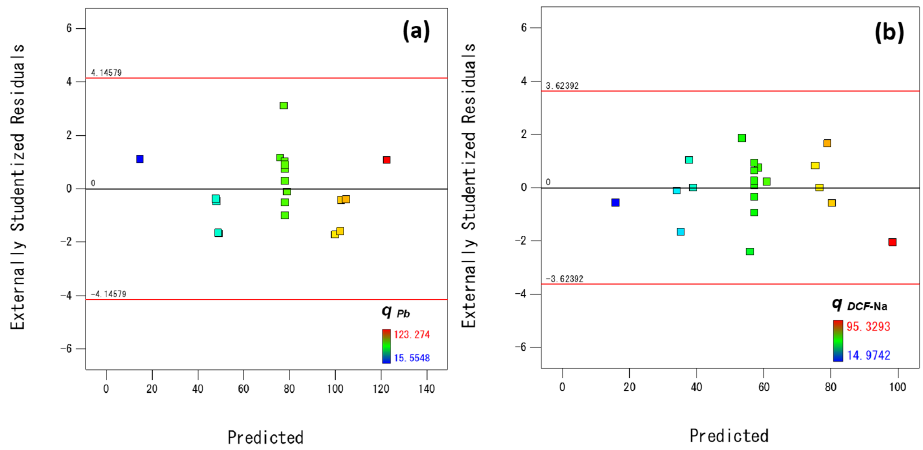
Polymers 2023 , 15 , x FOR PEER REVIEW 13 of 18 Figure 6. Diagnostic plots of residuals versus predicted responses for ( a ) q Pb and ( b ) q DCF ‐ Na. Figure 6. Diagnostic plots of residuals versus predicted responses for ( a ) q Pb and ( b ) q DCF ‐ Na. Figure 6. Diagnostic plots of residuals versus predicted responses for ( a ) q Pb and ( b ) q DCF-Na .